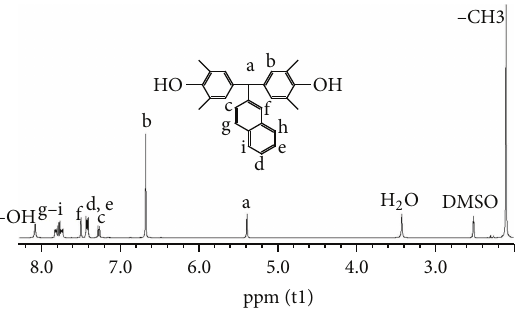
Figure 1: 1 H NMR spectrum of monomer 1 in DMSO-d 6